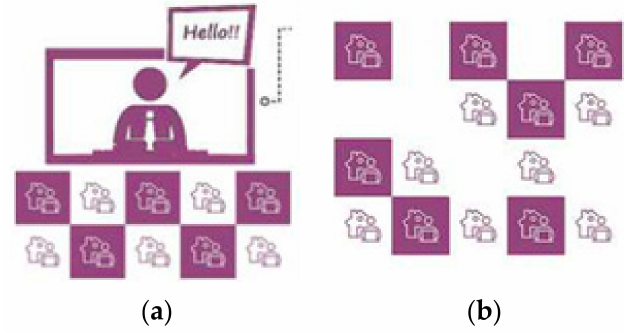
Figure 6. ( a ) Mixt modality; ( b ) Free